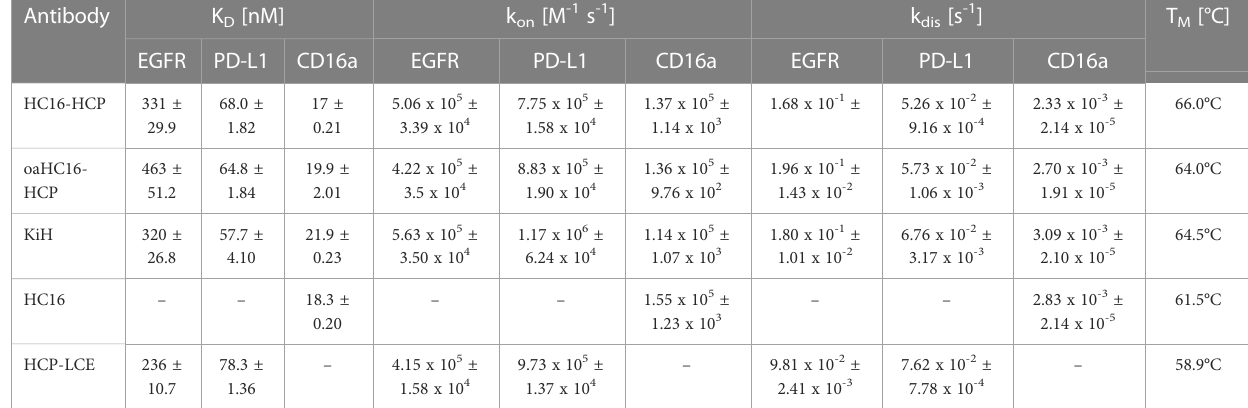
TABLE 1 Biophysical properties of HCP-LCE, HC16-HCP, oaHC16-HCP, KiH including af fi nity, kinetic binding rates and melting temperatures.